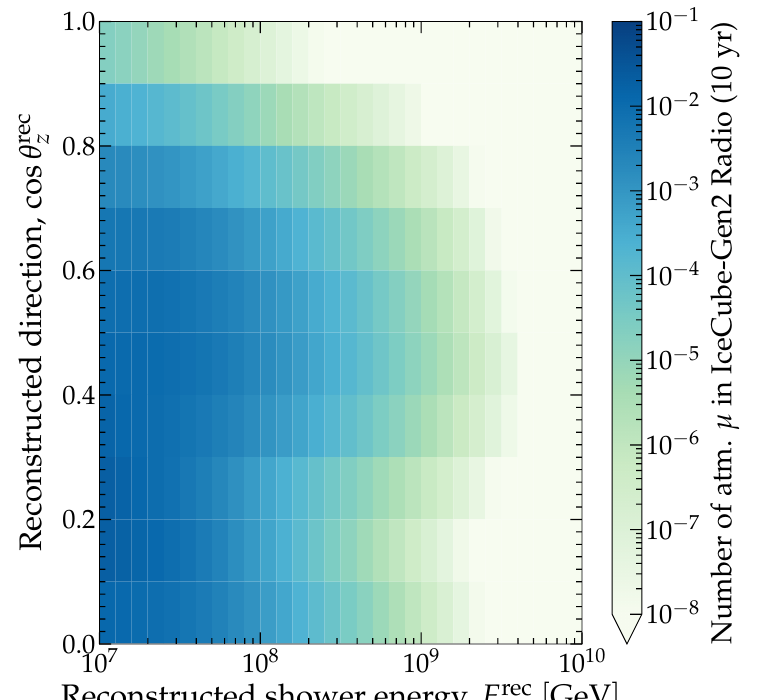
Figure 16 . Mean expected number of background showers initiated by high-energy atmospheric muons in the baseline design of the IceCube-Gen2 radio array in 10 years of exposure time. The energy and angular resolution are the same as the baseline choices for neutrino-initiated events, i.e., = 2 ◦ , respectively. The hadronic interaction model used is Sybill 2.3c [175]. The σ (cid:15) = 0 . 1 and σ θ z background rates in this plot and in our analysis are after the application of a cosmic-ray veto used to suppress the background. See the main text for